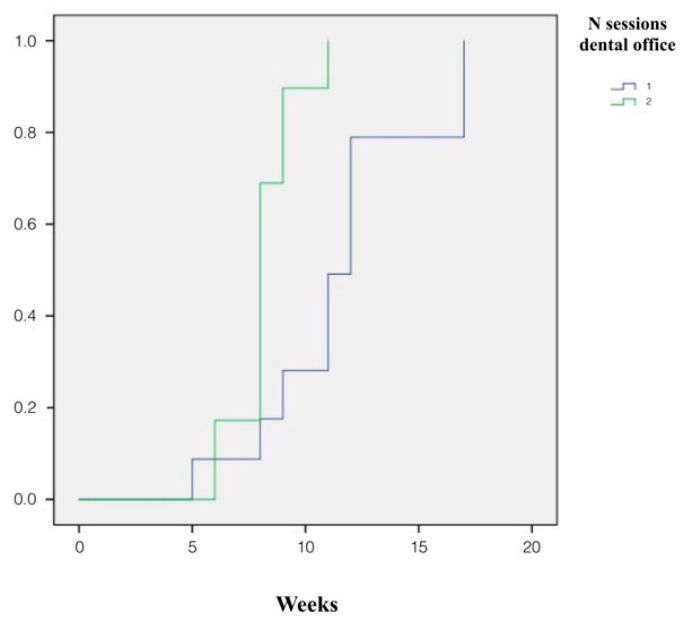
Figure 6. Survival curves (Kaplan–Meier method) of weeks required before reaching color stabilization in relation to number of in-office whitening sessions (one or two). N in-office sessions: blue line Group 1S; green line Group 2S. Appl. Sci. 2020 , 10 , x FOR PEER REVIEW